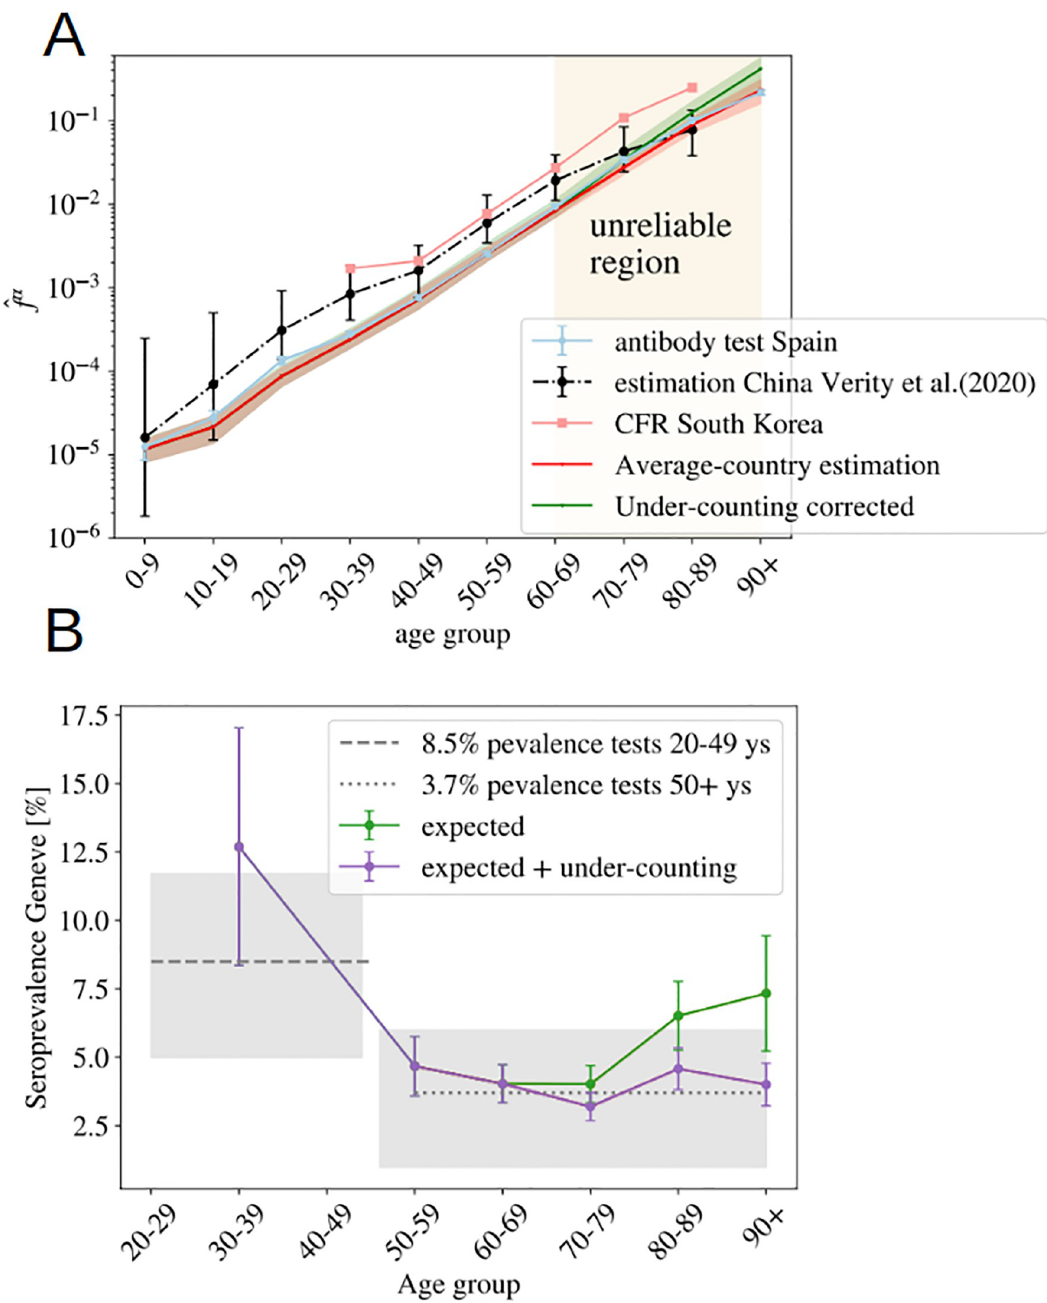
Fig 4. Probabilities assuming a uniform attack rate. A We use the measurements of the number of infections in Spain to estimate the UIFR using Eq (3) in both regions. We fix the constant ^ f in S2 Table using the estimation of the UIFR in Spain for the age group 0 50-59 to infer the values of the country average UIFR (from the collapse of Fig 3B). We show this first estimation in red, and in green, we show the UIFR after correcting the under-counting of deaths over 70 years old. We compare these results with the estimation by Verity et al . [25] and the CFR (i.e. the probability of dying for confirmed COVID-19 cases, not the IFR) by age in South Korea. In B , we use the IFR estimations from A ̠ and Table 1, to predict the seroprevalence of anti-SARS-CoV-2 antibodies in the population of Geneva, Switzerland, from the official distribution of deaths per age of a total of 277 deceases. The predicted fraction of infections is given in dots (in green, if we used the bare estimation of Eq (9), in violet, if we include the corrections linked to under-counting). In horizontal lines (and the 95% of confidence interval in gray shadow), we show the actual values measured from the antibody survey of Ref. [47] in patients of different